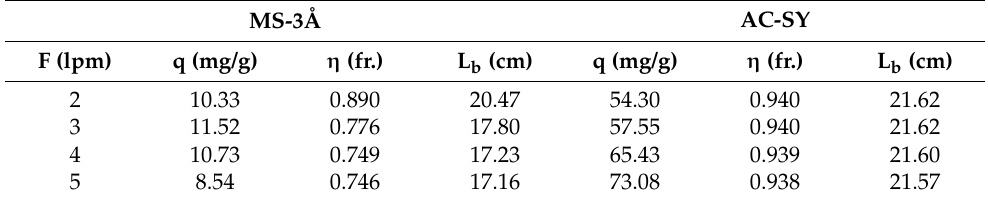
Table 4. Adsorption performances at various feed rates (T = 298 K, C in = 5%).